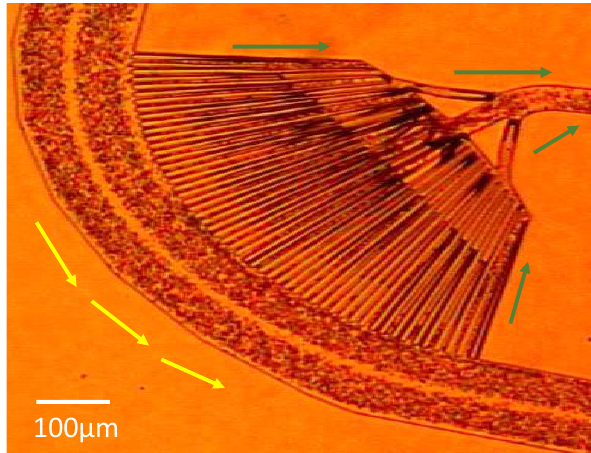
Figure 6. Blood cell separation in the curve channel. Once the sample flow moves along the curve channel, small cells (e.g., RBC) move along the suction channels (green arrow), while larger cells (e.g., WBC and others) move long the curve channels (yellow arrow). Q i = 100 µL/sec; Q s = 20 µL/sec. Chip 1 is used here as an example.